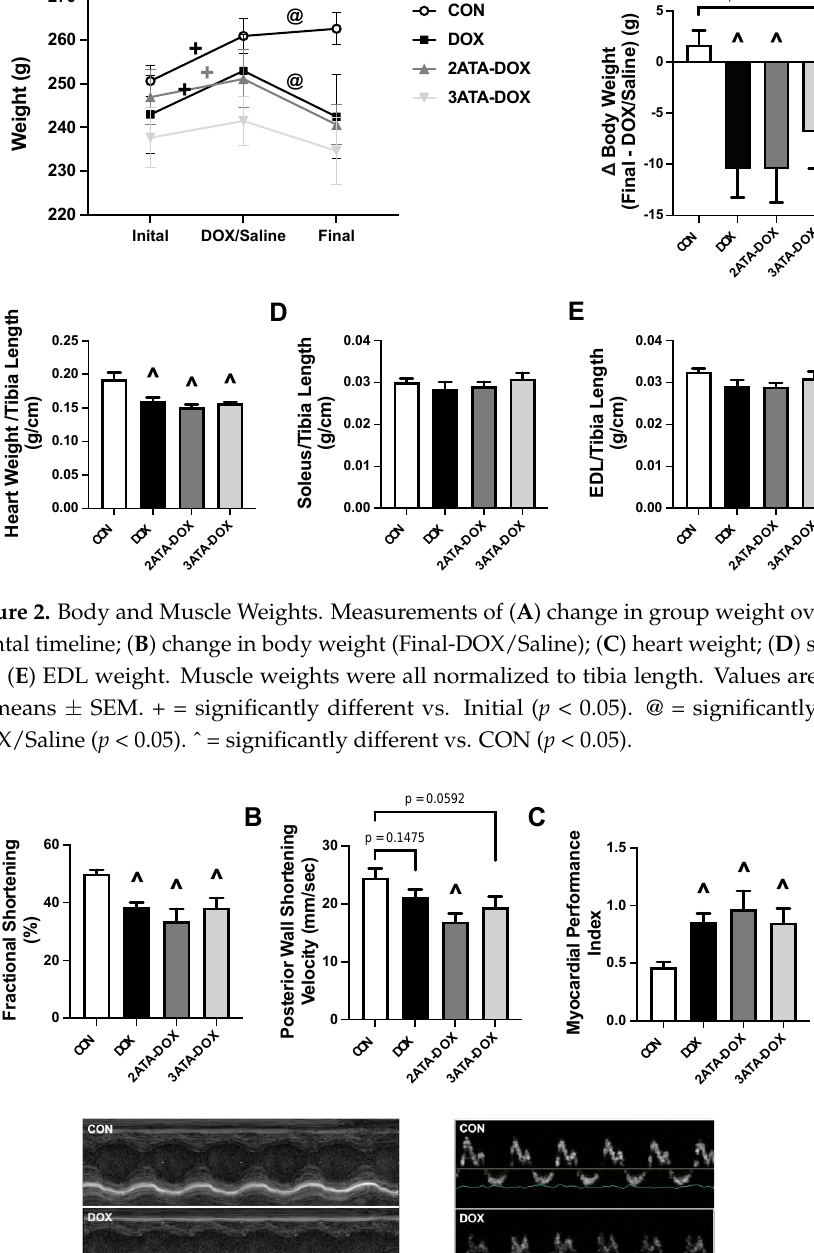
Table 1. Cardiac Function.